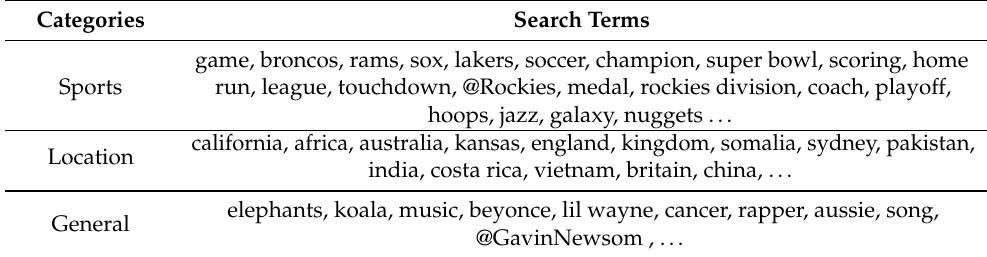
Table 2. Sample of the search terms for data cleaning and it’s corresponding